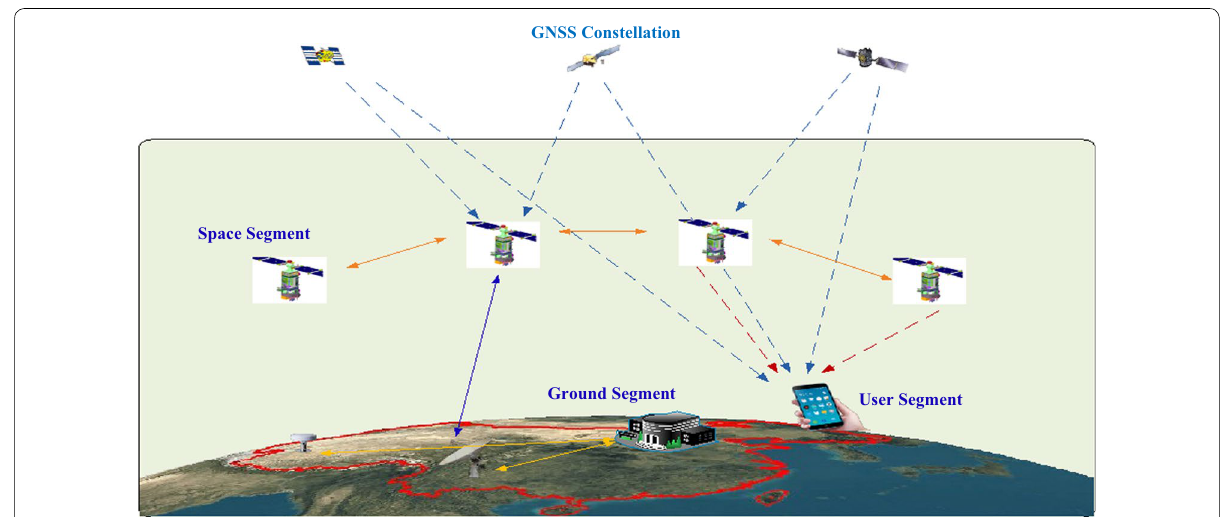
Fig. 9 The Centispace-1 LEO satellite-based augmentation system. Reference: Yang